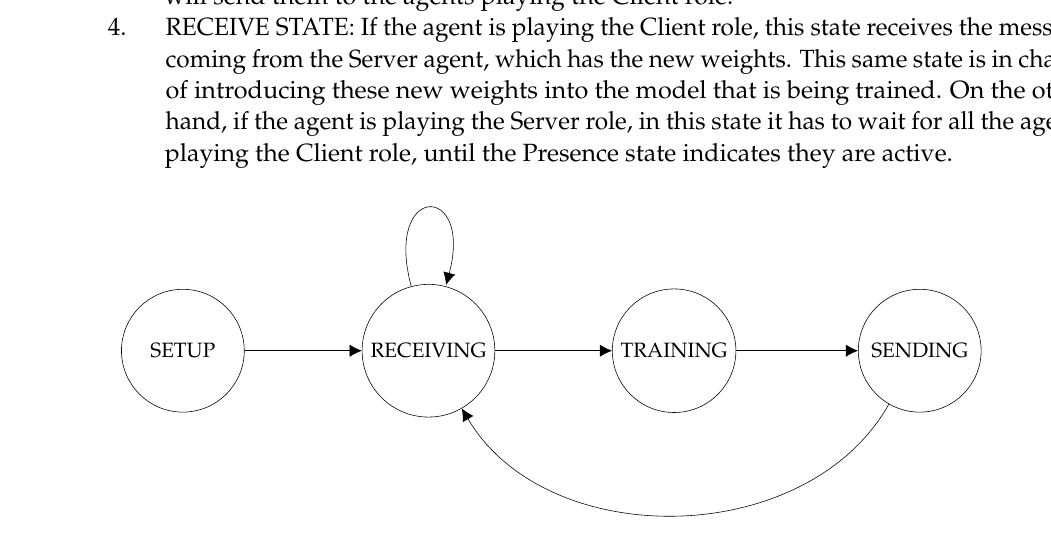
Figure 1. Finite state machine for the agents in the FLaMAS system. Figure 1. Finite State Machine for the agents in the FLaMAS system.